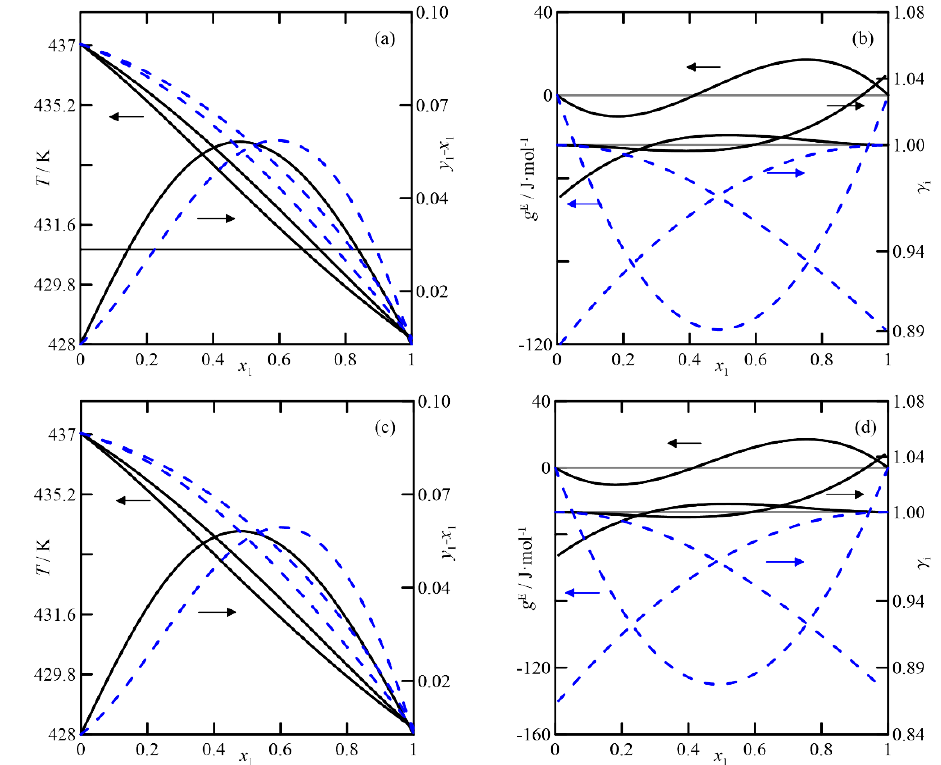
Figure 8. Estimations of VLE at 101.32 kPa of: ( a , b ), cyclohexanone + 2-cyclohexen-1-ol, and ( c , d ), cyclohexanone + 3-cyclohexen-1-ol. (—) UNIFAC-DM; (- - -) COSMO-RS.